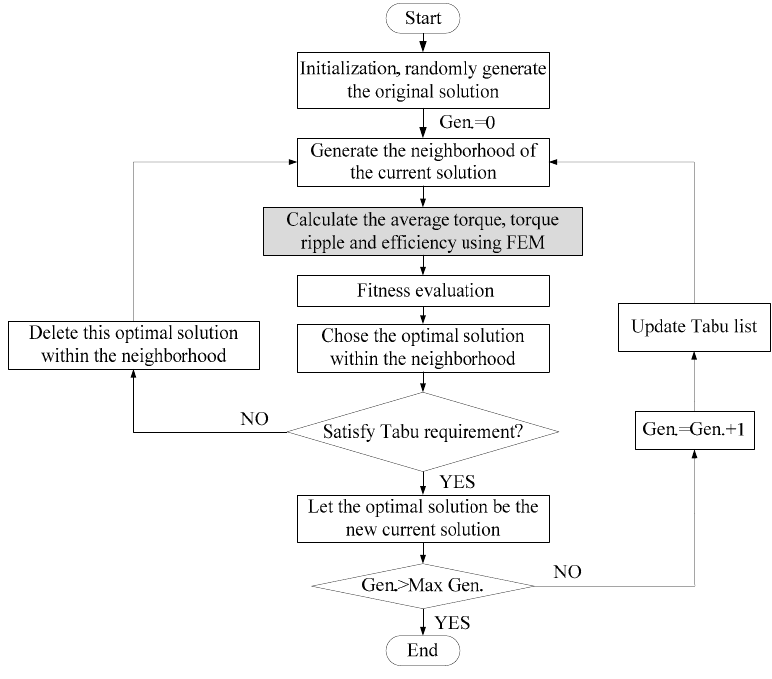
Figure 2. Flowchart of the optimization process. Table 1. Optimized parameters and their limits. DCF-HEM: DC-coil-free-hybrid excited machines; PM: permanent magnet.